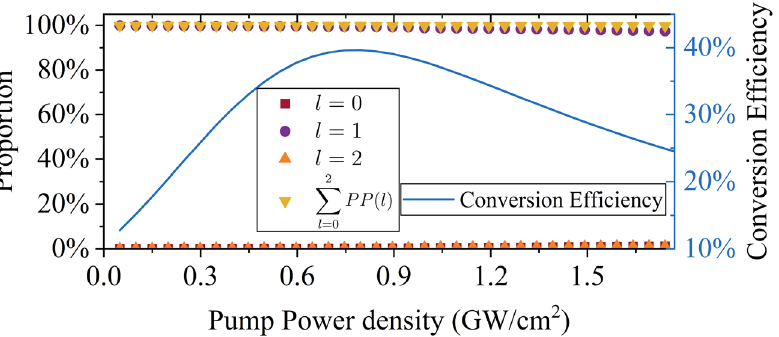
Figure 7. Change of OAM spectrum (left y-axis) and change of conversion efficiency (right y-axis) with different pump power